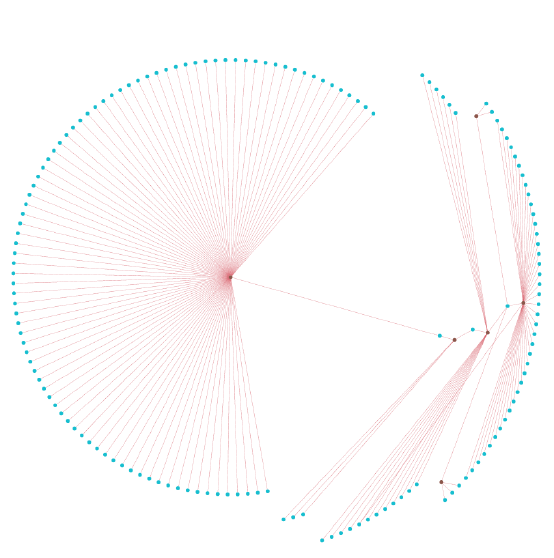
Figure 7. A subset of the graph produced by TigerGraph on the result of the query for all reviews in the Phoenix area in 2018. Maroon edges represent reviews. Blue vertices are the users and brown vertices represent the